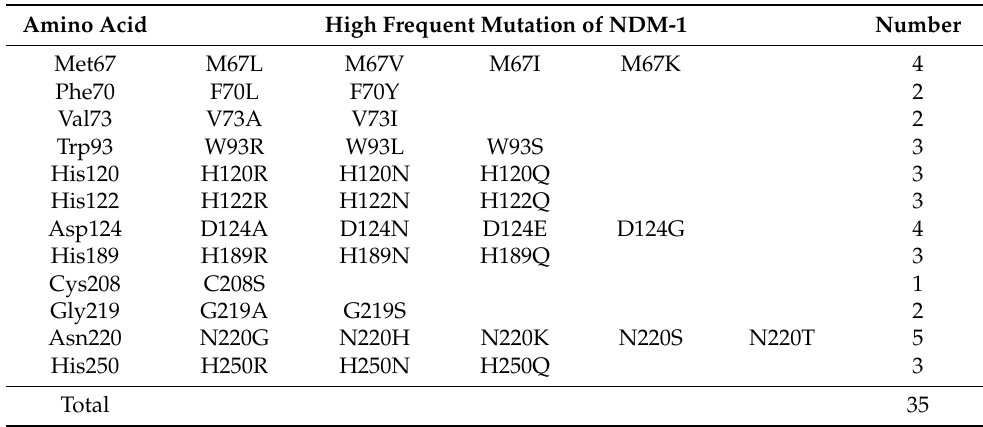
Table 1. High probable mutation of NDM-1 protein according to PAM-1